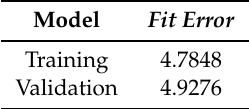
Table 2. The prediction error between the subspace based metabolite rate model and the process for both the training and validation batches.